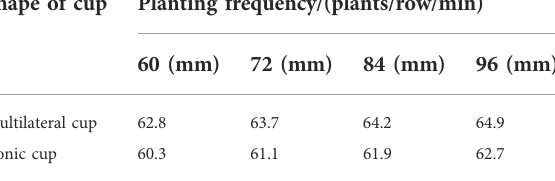
TABLE 7 Effective depths of planting